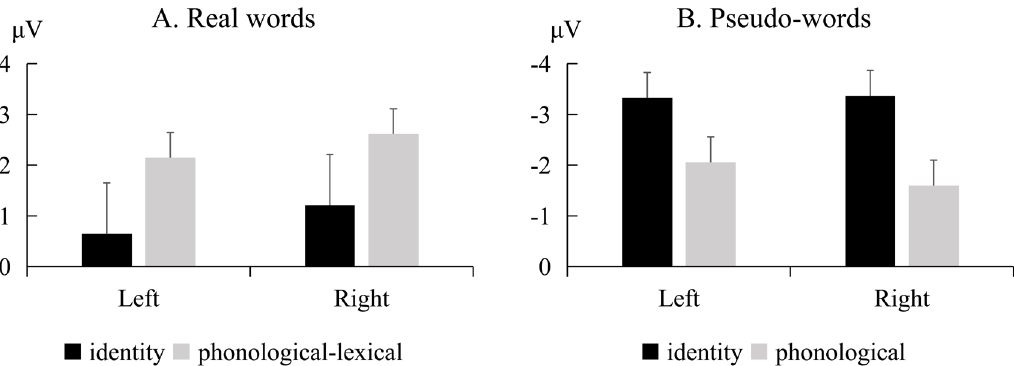
Figure 4. MMN amplitudes in the real words’ ( A ) and pseudo-words’ ( B ) deviant conditions. Error bars represent one standard error.